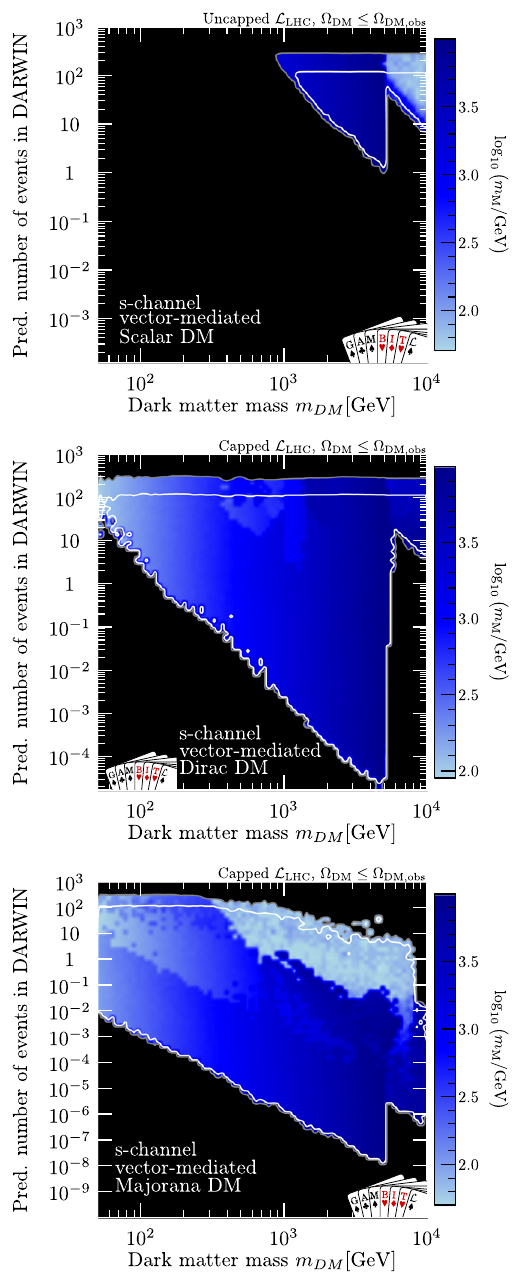
Fig. 11 Mediator mass as a function of the predicted number of signal events in the DARWIN experiment. Capped collider likelihoods are shown for Dirac (middle) and Majorana (bottom) DM as these are the least constraining. The non-capped likelihood is shown for the scalar DM model (top). The contour is coloured to indicate the mediator mass that gives the highest likelihood for a given DM mass potential to produce tens or even more than a hundred